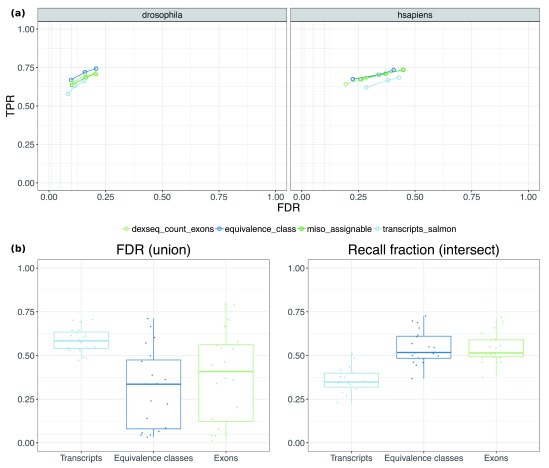
The performance of the equivalence class method for differential transcript usage.(
a) The equivalence class method compared to other state-of-the-art methods on simulated data described in Soneson
et al.
6. The circles show the observed true positive rate (TPR) versus false discovery rate (FDR) at three nominal FDR cut-offs (0.01, 0.05 and 0.1) for each method. The dotted lines indicate the FDR at the nominal cut-off values of 0.01, 0.05 and 0,1 (i.e. if the FDR is adequately controlled, the three circles should match up with these lines). (
b) The ability of the equivalence class, transcript and exon-based methods to recreate the results of a full comparison (10 vs. 11) of the Bottomly data, using only a (randomly selected) subset of samples (3 vs. 3) across 20 iterations using FDR < 0.05 (FDR = 0.05 is indicated by the dotted line). The union of all genes called as significant across all three methods is used to calculate the FDR, and the intersect (genes called by all three methods) is used for the TPR. Full results (union, intersect and each method’s individual truth set) are shown in Supplementary Figure 3, which also shows lines connecting the results from each iteration.